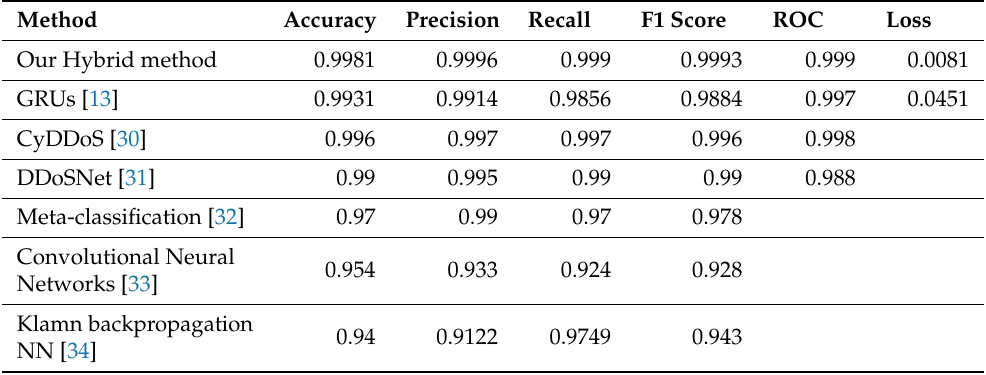
Table 3. Comparison with other